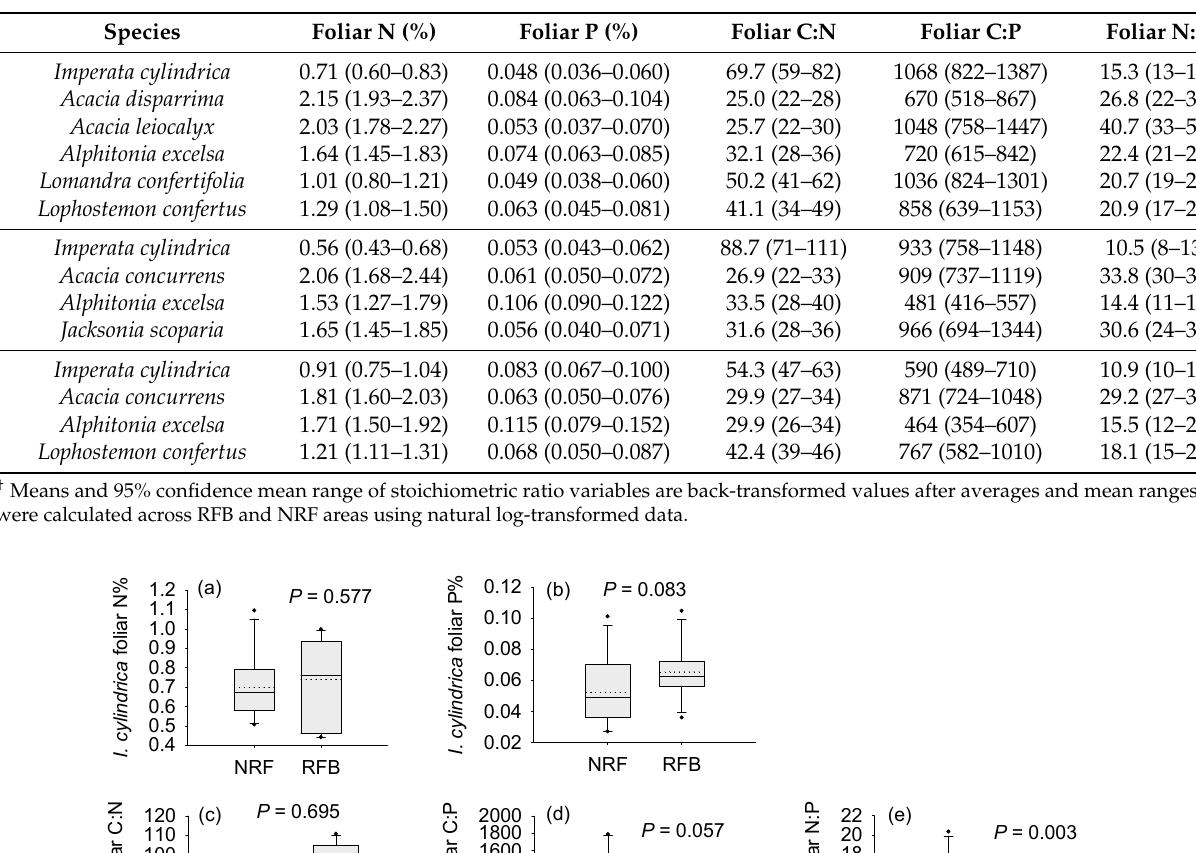
Table 4. Foliar nitrogen (N) and phosphorus (P) concentrations and carbon (C):N:P stoichiometric ratios (means † , with 95% confidence mean range shown in brackets) of Imperata cylindrica and several naturally occurring understory plant species at each of the three study sites.